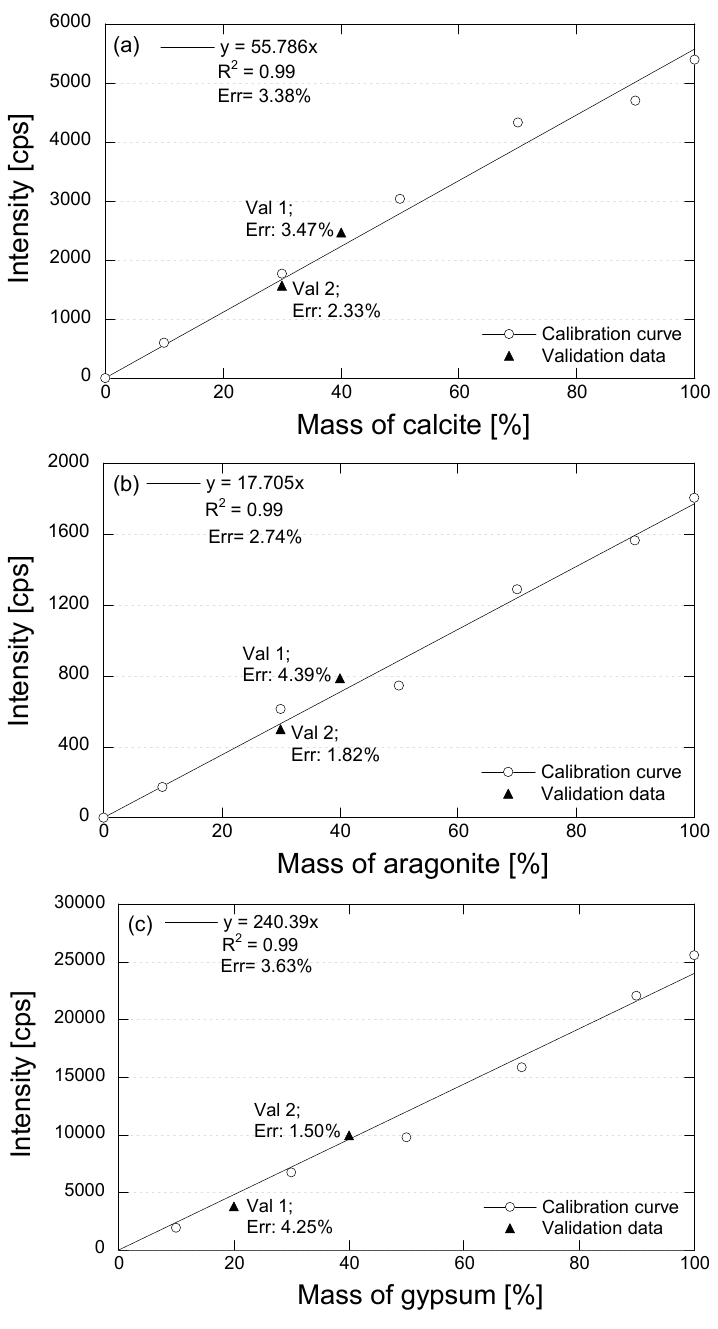
Figure 7. Calibration curve for XRD quantitative analysis: ( a ) calcite; ( b ) aragonite; and ( c ) gypsum.